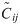
Positional conservation (Di) and the SCA weighted correlation matrix C˜ij for the G protein family.A-B, The overall positional conservation Di for the G protein alignment, and a corresponding mapping on a slice through the core of the atomic structure of a representative member of the family (human Ras, PDB 5P21). The data show that the top 50% of conserved positions (in red) lie at functional surfaces and within the solvent inaccessible core. Thus, positional conservation maps to an intuitive and a well-known decomposition of protein structures. C-D, C˜ij ordered by primary structure (C), and after hierarchical clustering (D). The data describe a sparse and seemingly hierarchical organization of correlations—a general result for most protein families.